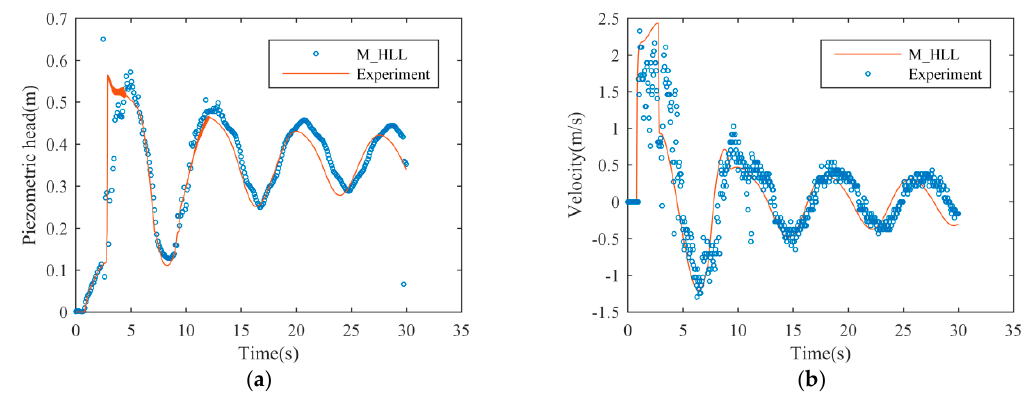
Figure 25. Locus of flow states at x = 6.8 m simulated by M_HLL ( K a = 1.4 and NS = 5) and experimental data: ( a ) piezometric head; ( b ) flow velocity.